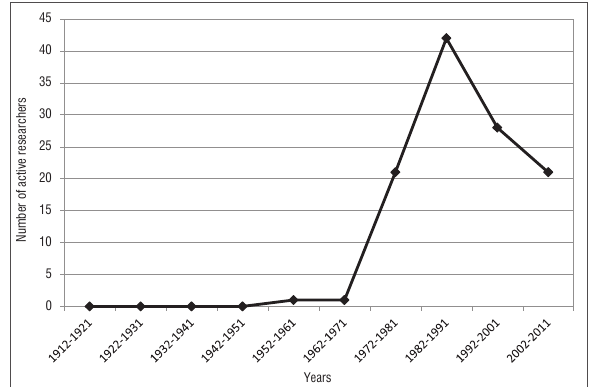
Figure 2: A decadal analysis of the number of references in different categories over the past century. The total number of publi- cations in each decade is also shown.